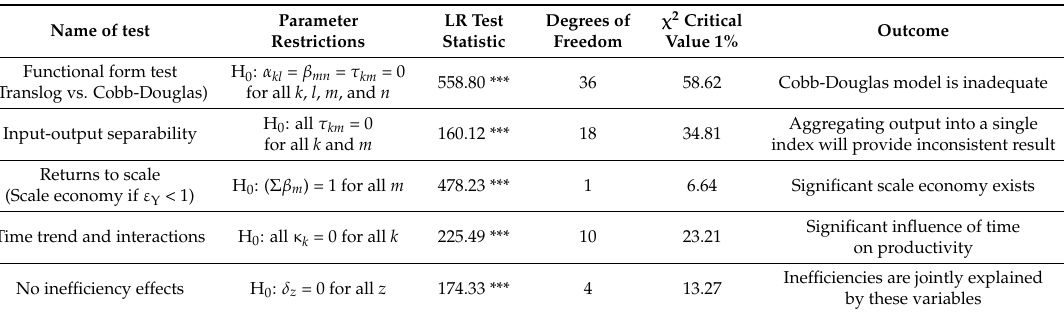
Table 4. Hypothesis tests.